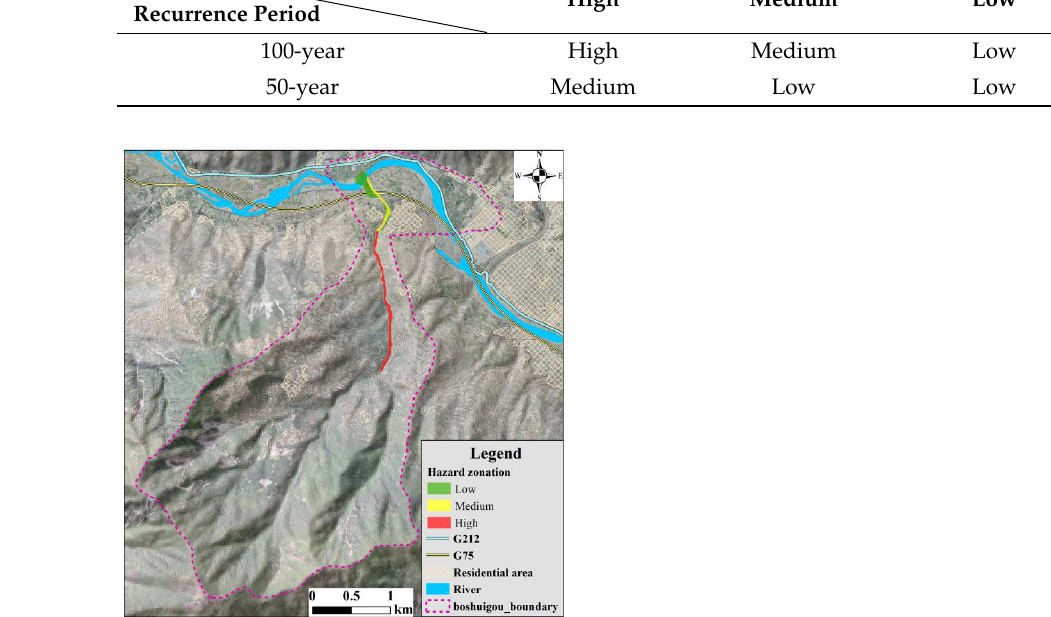
Figure 9. Hazard zonation of the Boshuigou debris flow.